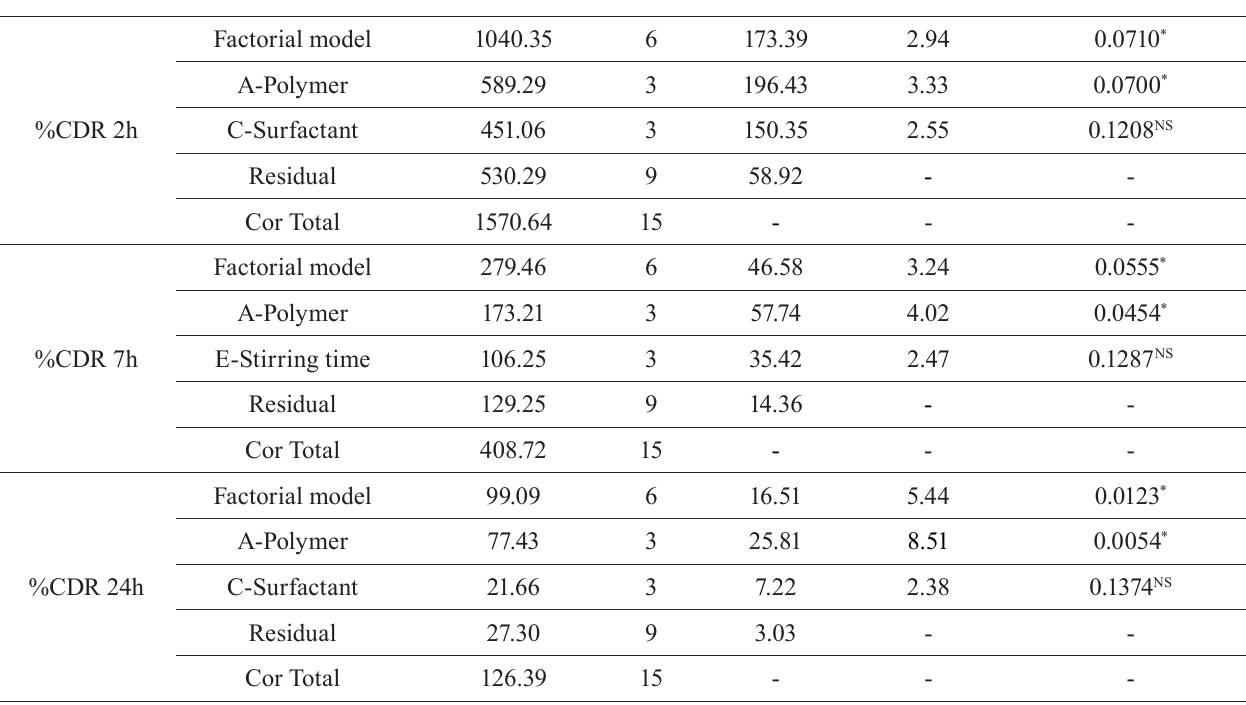
*Significant, NS Not Significant, CDR- Cumulative drug release